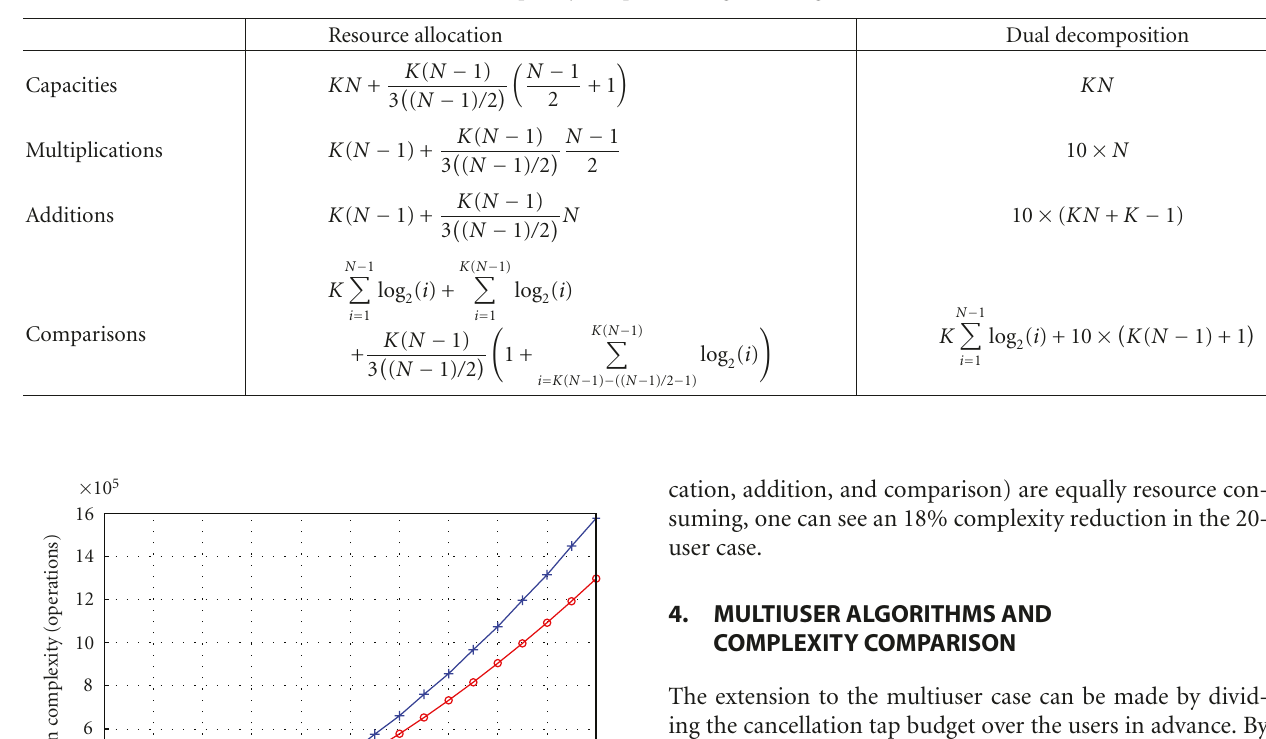
Algorithm 3: Single-user dual decomposition algorithm. Table 1: Complexity comparison single-user algorithms.